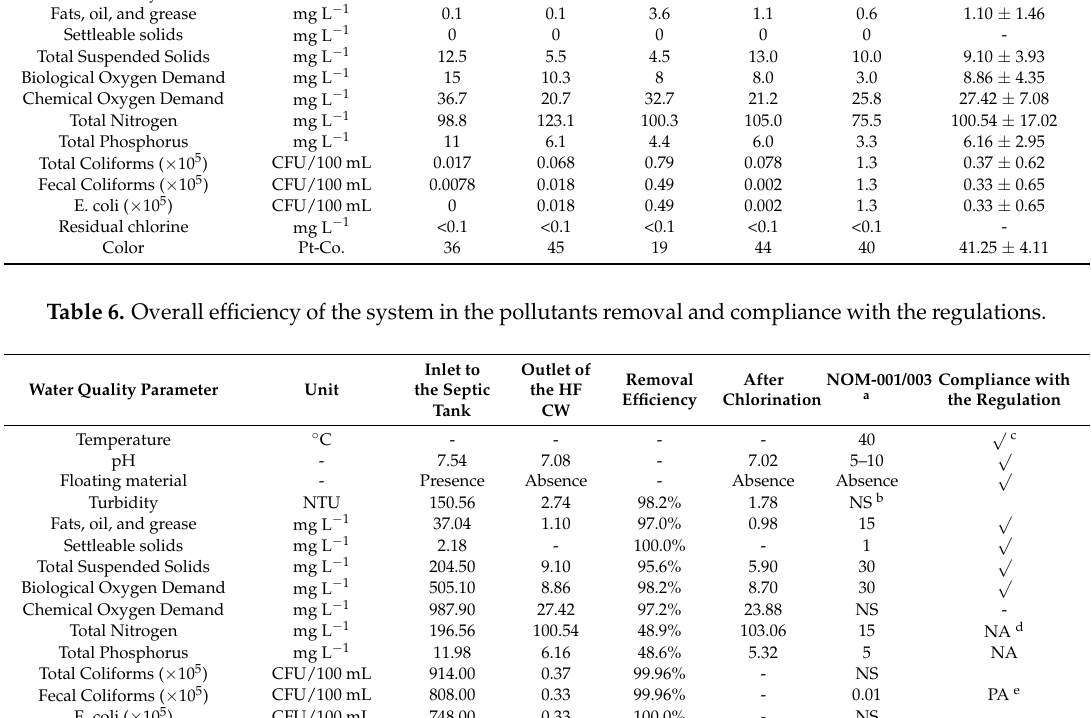
Table 5. Water quality parameters at the outlet of constructed wetland (SD = standard deviation).